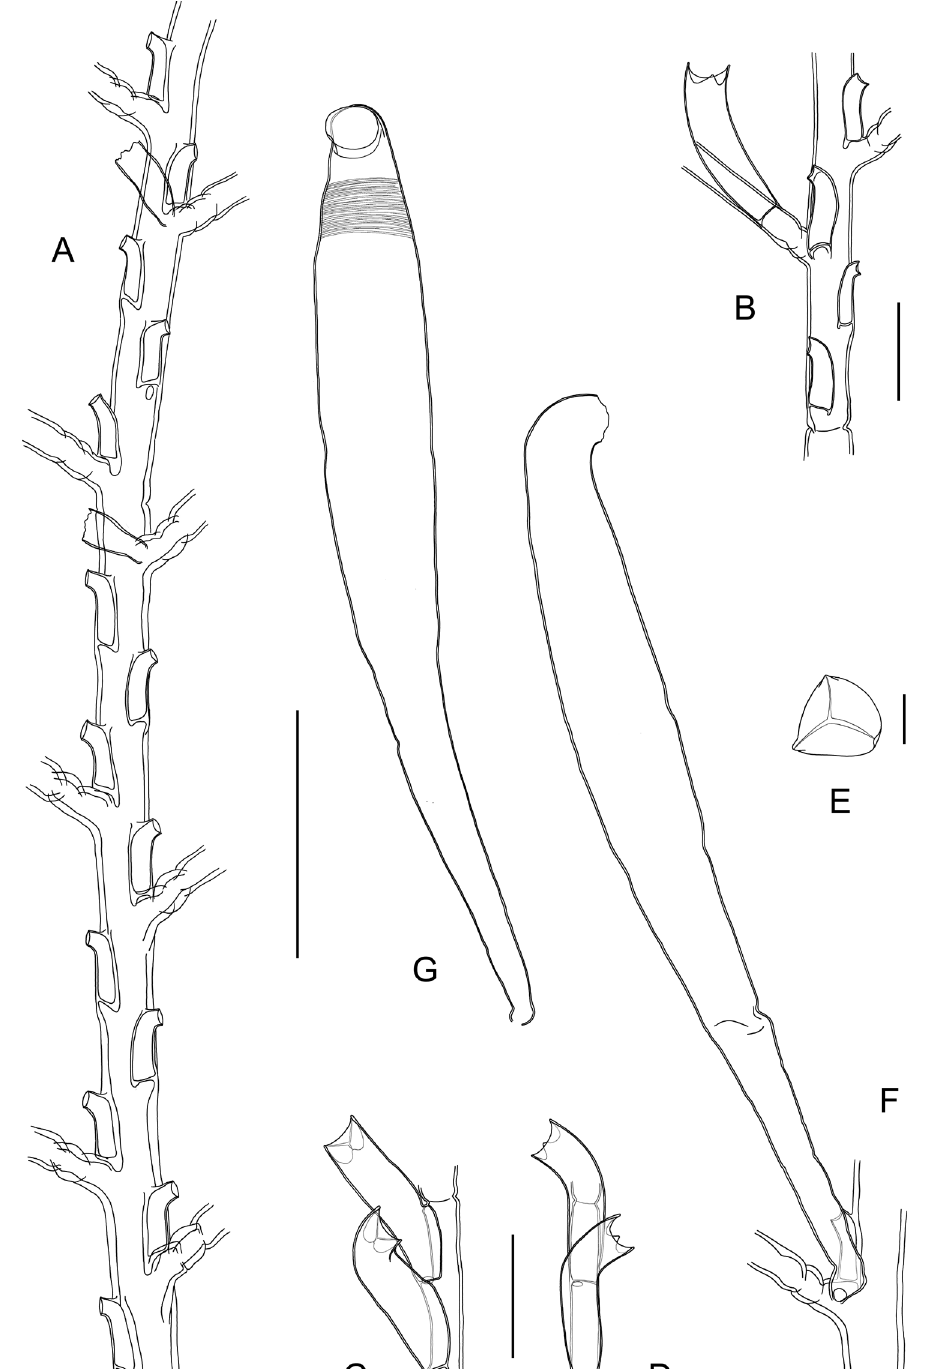
Fig. 12. Hydrallmania clavaformis Galea, sp. nov. A–G . Portions of branch with insertion of cladia (A–B), cladial internode in lateral (C) and apical (D) aspects, opercular apparatus (E), gonotheca in lateral (F) and frontal (G) aspects, all from sample MNHN-IK-2015-404. Scale bars: A–B = 1 mm; C–D = 500 µm; E = 100